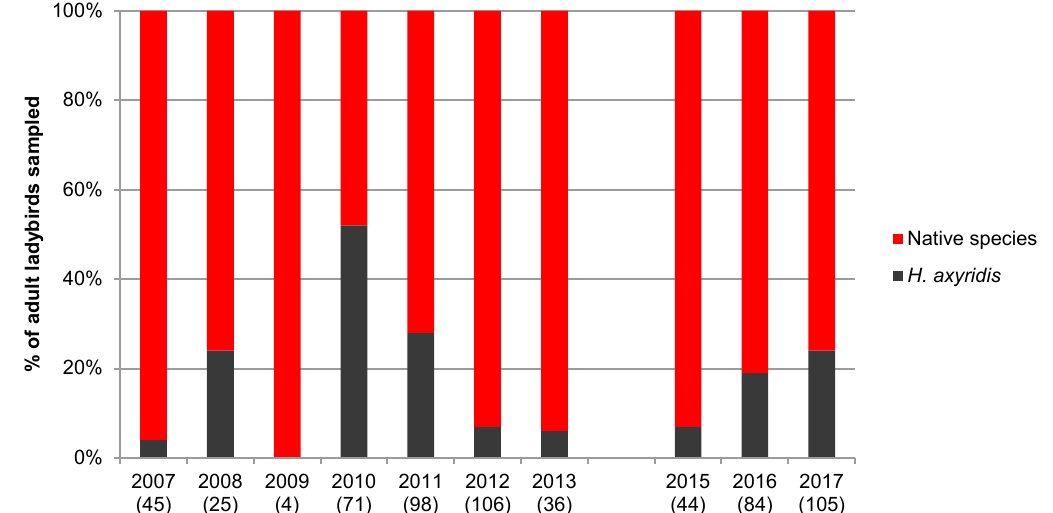
Figure 3. Percentage of Harmonia axyridis and native species at the five pine sites from 2007 to 2017. Numbers between parentheses indicate the number of adult ladybirds collected. Table 3. Species and number of adult ladybirds collected at the five pine sites from 2007 to 2017. Numbers between parentheses indicate the number of collections. Ladybirds were not sampled in 2014.